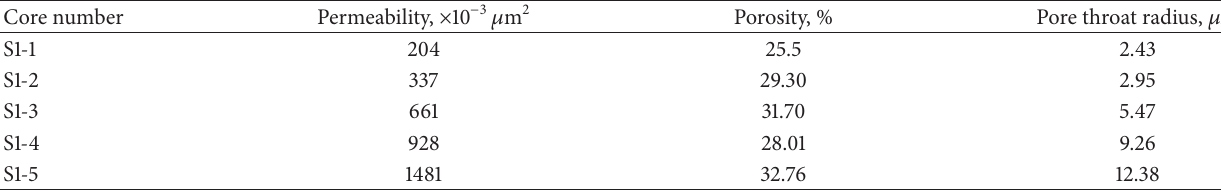
Table 4: Pore throat parameters of target block S.